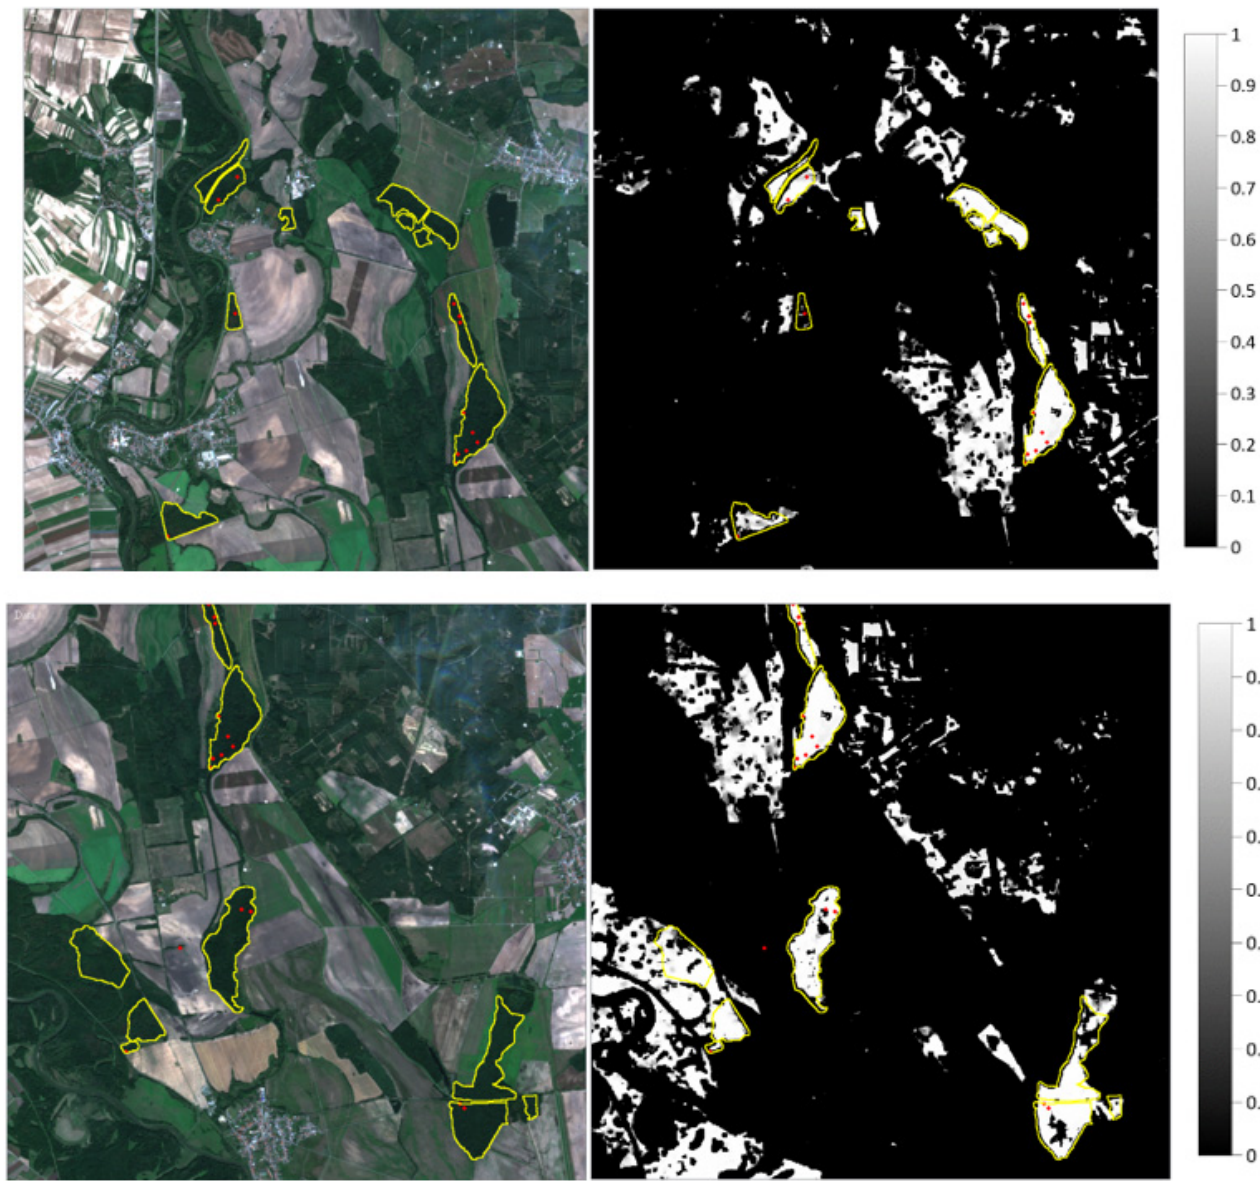
Figure 10. Relevancy maps for the 91F0 habitat compared with segmentation curves (yellow), and phytosociological relevés location (red points). The values 0–1 represent a measure of relevancy of habitat occurrence from the highest (1) to lowest (0) probability. All pictures are standardly north oriented on upper side of the figure. The Sentinel-2 data from 9 September 2018, covering Western Slovakia, were used for learning phase and computation of relevancy maps.